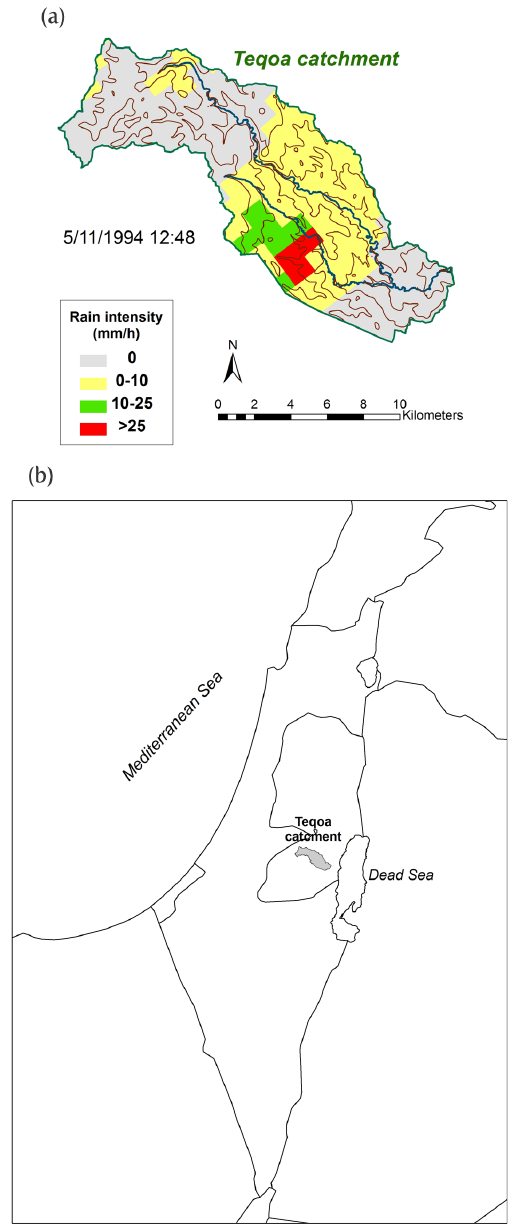
Fig. 6. Teqoa Event occurring in November 1994. (a) Radar-based rainfall intensities over the Teqoa catchment for 12:48 (local time), brown contour lines represent elevation (0–900m in 100m inter- vals), and, (b) general location of the Teqoa catchment.